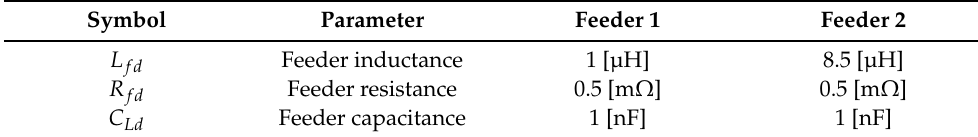
Figure 17. Simulation results of bus 2 with parameters of Feeder 2, time ( left ) and harmonic ( right ) responses. ( a ) grid voltage and its harmonic response; ( b ) Norton model and its harmonic response. Table 5. Feeder parameters under